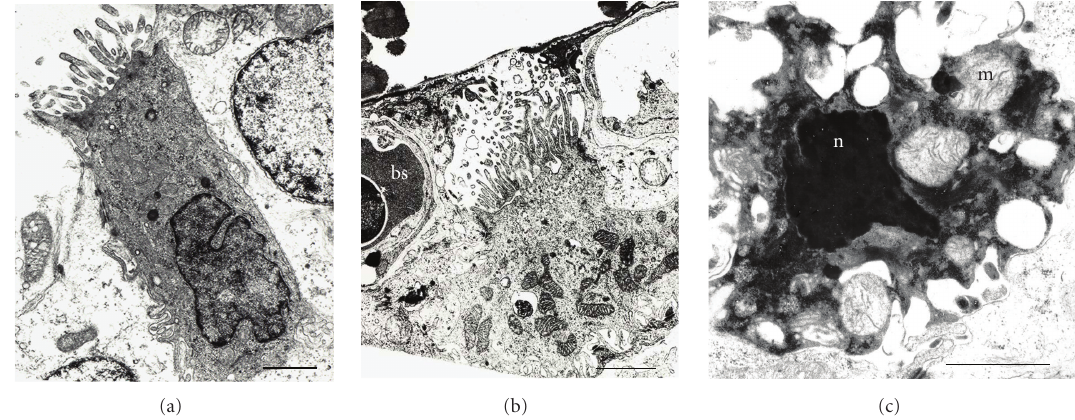
Figure 3: VC cells at early stage of di ff erentiation ((a) original magnification: 19,600x; scale bar: 2 μ m) are present in the CAM at day 13 of incubation, interspersed among the fully di ff erentiated ones (b, original magnification: 11,000x; scale bar: 3 μ m). Also elements with the appearance of apoptotic cells are frequently observed (c) original magnification: 33,000x; scale bar: 3 μ m). blood sinus (bs); m, mitochondria; n, nucleus. M. G. Gabrielli,